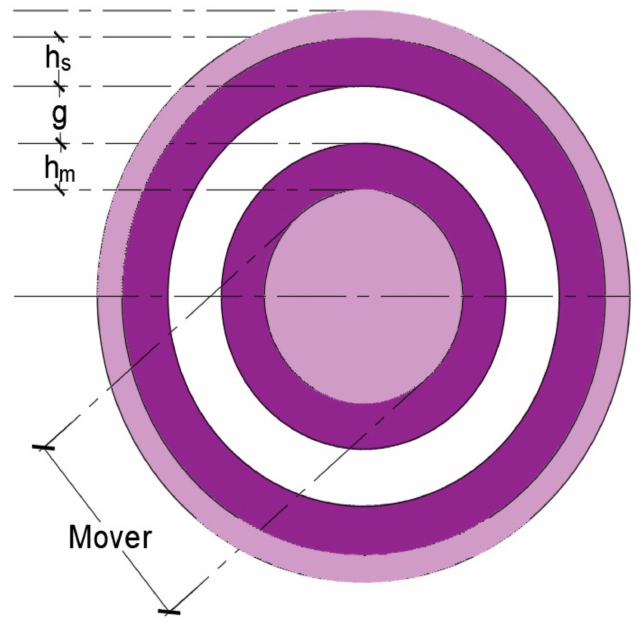
Figure 3. TLSM’s cross-section around one pole pitch long